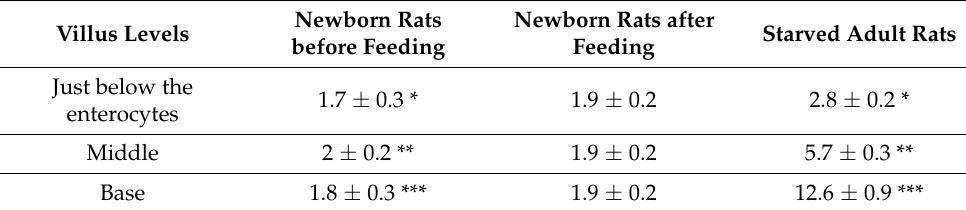
Table 1. The ratio between the longitudinal and transverse diameters on the cross-sections of the intestinal villi of white rats (shape factor). Newborn Rats Newborn Rats after Villus Levels Starved Adult Rats before Feeding Feeding Just below the 1.7 ± 0.3 * 1.9 ± 0.2 2.8 ± 0.2 * enterocytes Middle 2 ± 0.2 ** 1.9 ± 0.2 5.7 ± 0.3 ** Base 1.8 ± 0.3 *** 1.9 ± 0.2 12.6 ± 0.9 *** *, ** and ***: difference between means is significant ( p <